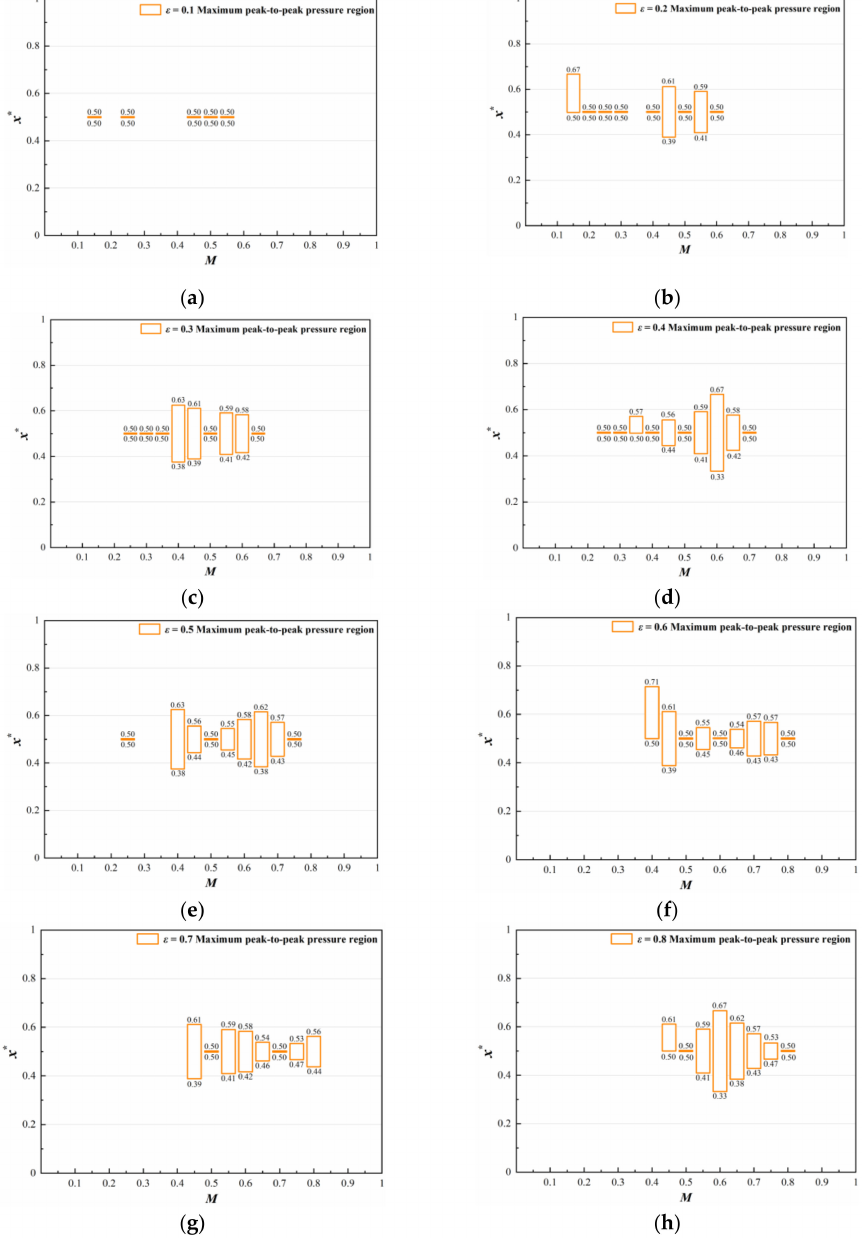
Figure 10. Distribution of the maximum peak-to-peak pressure region under different train/wave velocity ratios M and train/tunnel length ratios ε ( M ≤ 0.8, ε ≤ 0.8): ( a ) ε = 0.1; ( b ) ε = 0.2; ( c ) ε = 0.3; ( d ) ε = 0.4; ( e ) ε = 0.5; ( f ) ε = 0.6; ( g ) ε = 0.7; and ( h ) ε =